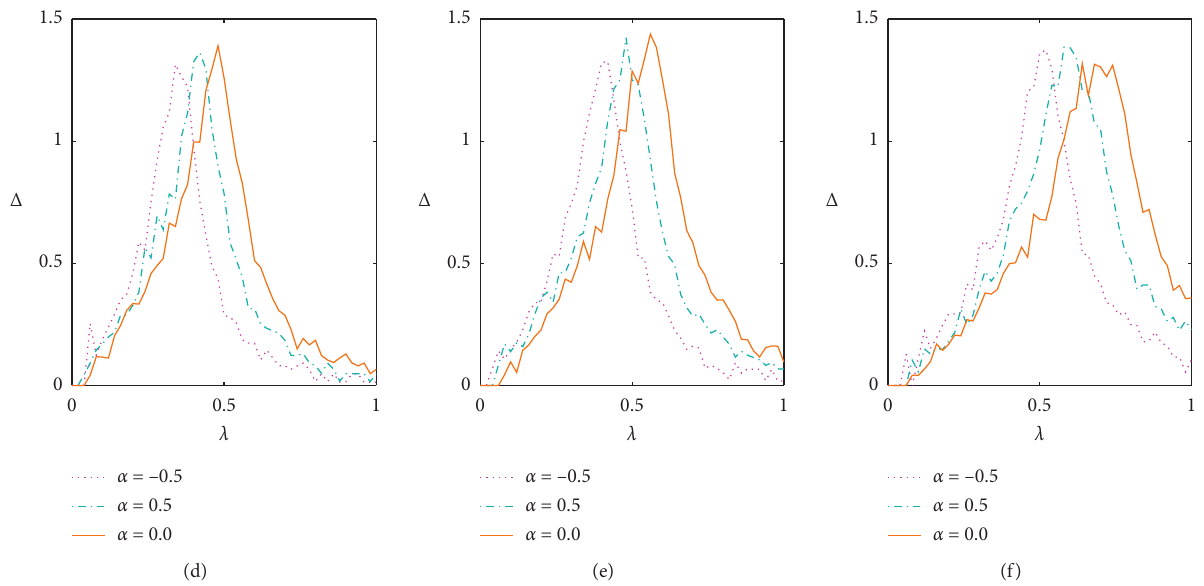
Figure 4: The variation of the outbreak size R ( ∞ ) with the transmission probability λ with different preference selection parameters β . (a) ( β � − 1), (b) ( β � 0), and (c) ( β � 1). The symbols and lines are the simulated and theoretical values of R ( ∞ ) in (a)–(c), respectively, where α � − 0 . 5 (pink triangles), α � 0 . 0 (orange squares), and α � 0 . 5 (blue-green circles). The arrows are theoretical outbreak threshold. The simulated outbreak threshold Δ as a function of λ with β � − 1 (d), β � 0 (e), and β � 1 (f) for the corresponding values of α in (a)–(c), respectively. Another parameter is f � 0 .